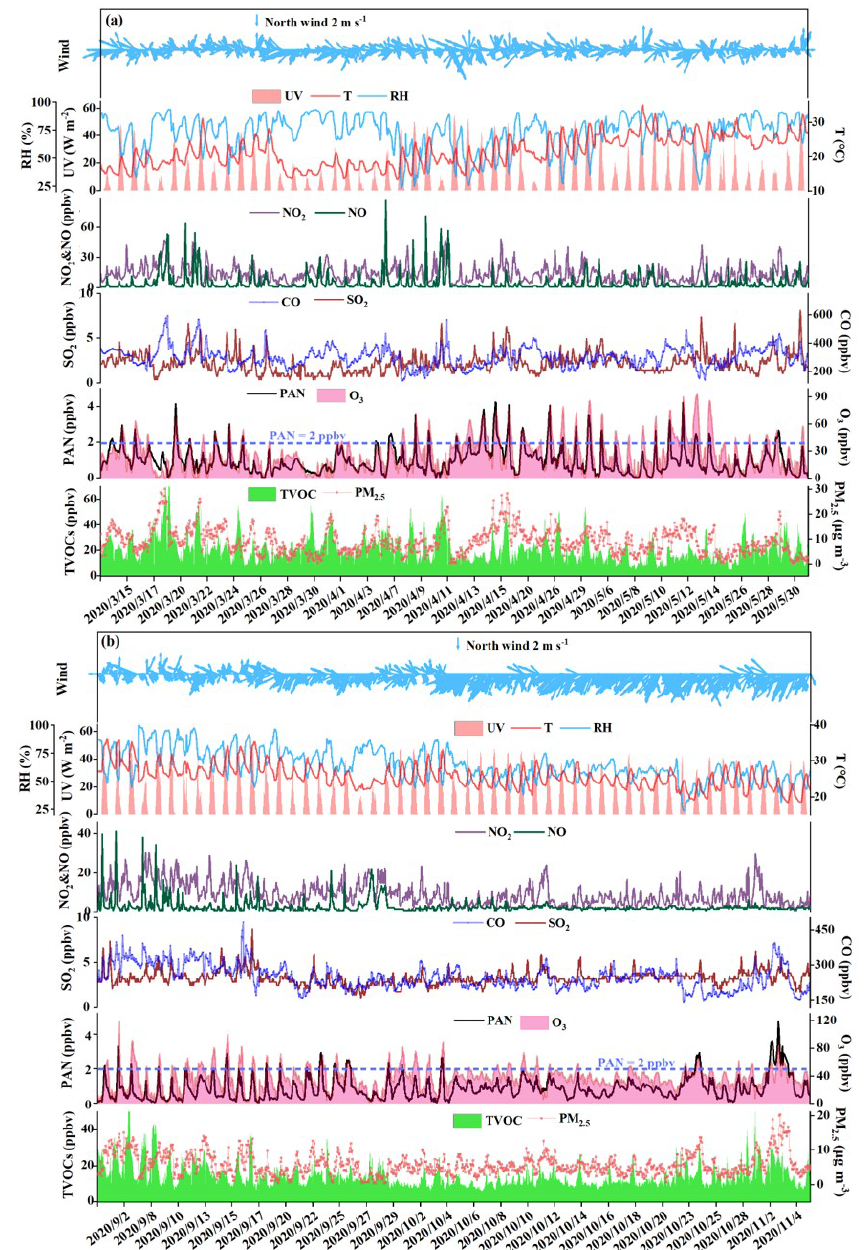
Figure 2. Time series of PAN, O 3 , NO x , CO, SO 2 , TVOCs, PM 2 . 5 , and meteorological parameters in (a) spring and (b) autumn.